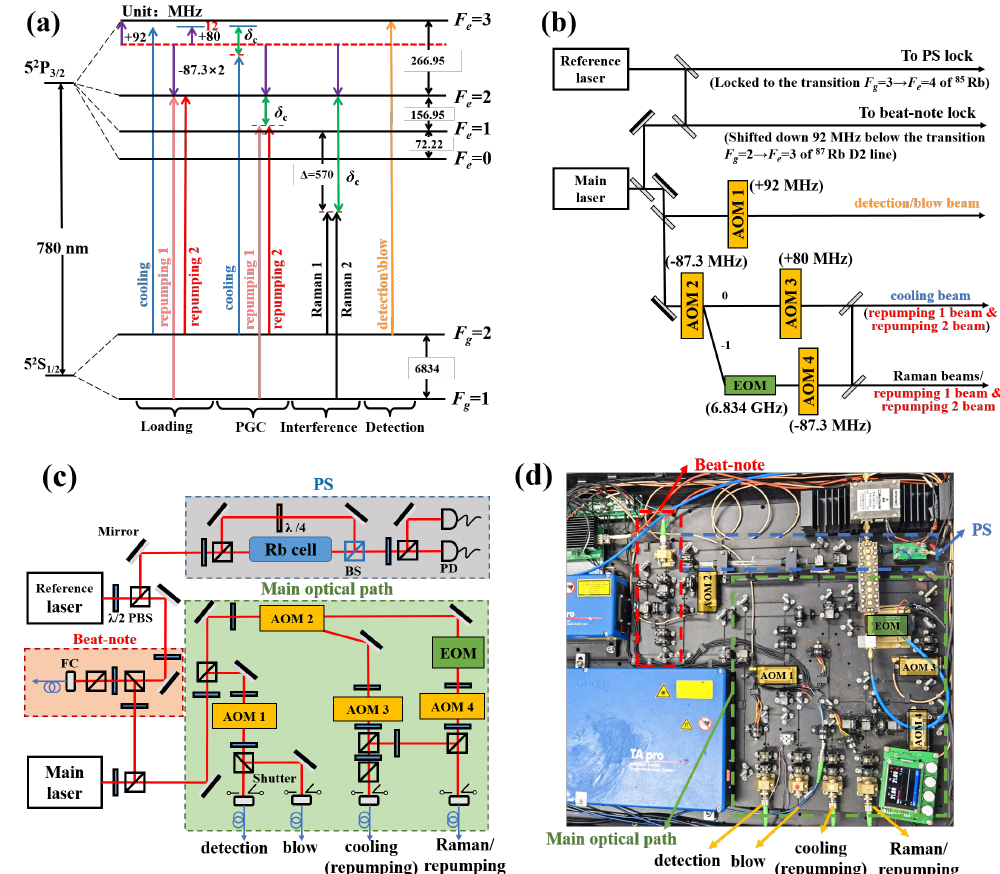
Figure 1. The system scheme of AI: ( a ) D2 transition diagram of the 87 Rb and laser frequencies needed for AI. The purple line represents the frequency of acoustooptic modulator (AOM) and the green line represents the frequency of frequency voltage convert (FVC); ( b ) The frequency scheme for AI; ( c ) The diagram of optical path. The gray area denotes the polarization spectrum (PS), the green area shows the main optical path, and the red area represents the optical path of the beat-note module. ( λ /2: half-wave plate; PBS: polarization beam splitter; FC: fiber collimator; λ /4: quarter-wave plate; BS: beam splitter; PD: photo diode; and Rb cell: rubidium vapor cell) ( d ) the photograph of the optical